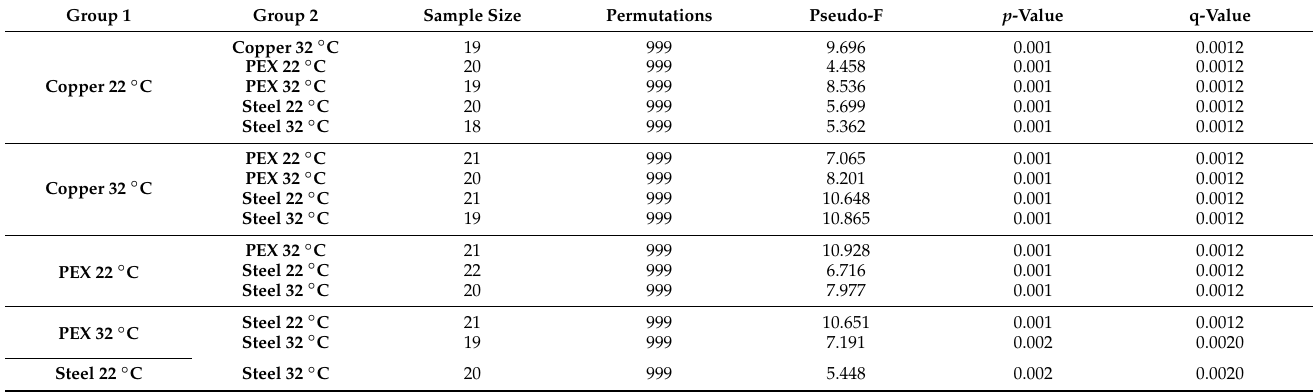
Table 2. Pairwise PERMANOVA comparison of microbial composition (beta diversity) based on pipe material and temperature condition.